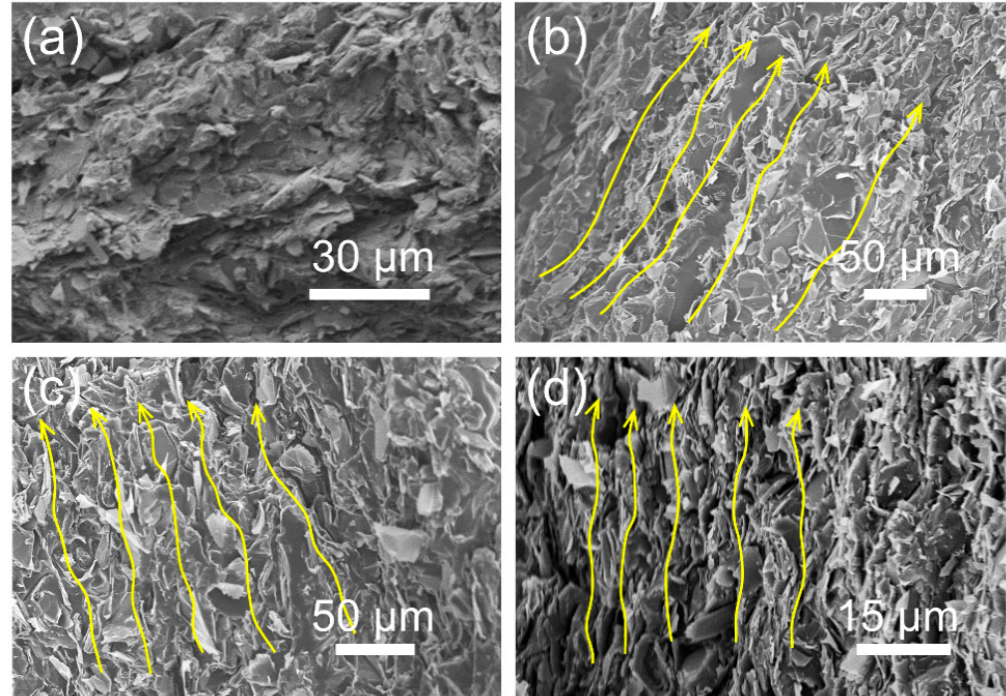
Figure 4. SEM images of ( a – d ) random GP / PU, 3D-GP5 / PU, 3D-GP60 / PU, and 3D-GP196 / PU composites, respectively. Yellow arrows indicate the direction of graphite and GO.